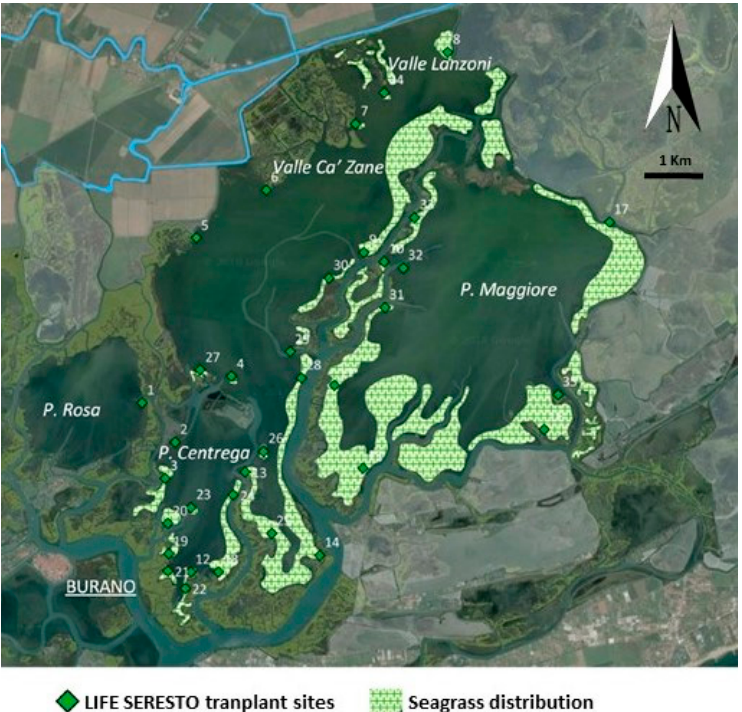
Figure 4. Map of seagrass distribution in the LIFE SERESTO project area (spring 2018) [58], modi- fied.